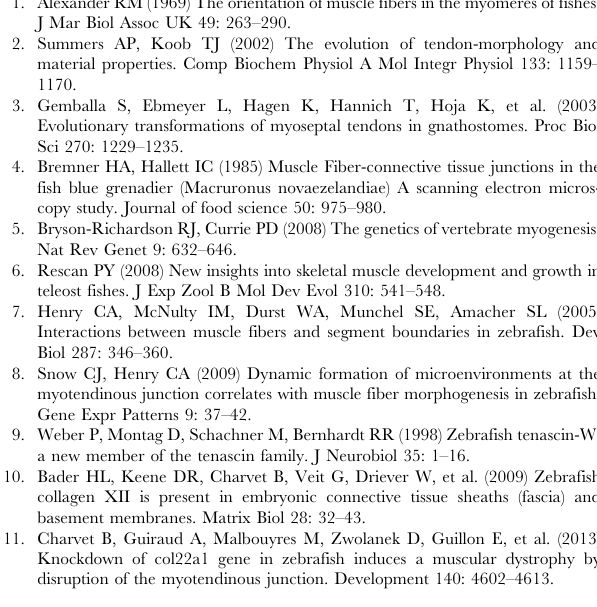
trout embryo. Nuclei were stained with Hoechst. Labelling is observed in rare myoseptal cells (arrow). Scale bars, 30 m m. (TIF) Figure S3 Comparison of the predicted trout and murine angiopoietin-like 7 protein sequence. Shading indicates identity. (TIF) Figure S4 Expression of col5a2 (A) and col12a1 (B) in a trout embryo at stage 13 dpf (somitogenesis is not completed). Frontal sections. Collagen V and XII transcripts strongly accumulate in the dermomyotome-like epithelium (arrow) at the surface of the primary myotome (PM). Note that labelling for col12a1 is still reduced in sclerotome-derived cells surrounding the notochord. Scale bars in A and B, 30 m m. (TIF) Figure S5 Comparison of the predicted trout and murine scleraxis protein sequences. Shading indicates identity. The highly conserved bHLH domain is marked with a bar. (TIF) Figure S6 Comparison of the predicted trout and murine Osteoblast-specific factor2/Periostin protein sequence. Shading indicates identity. Positions of the signal sequence (green segment), the cysteine-rich region (blue segment) and the four fasciclin I-like repeats (R1-4) (red segments) are indicated.